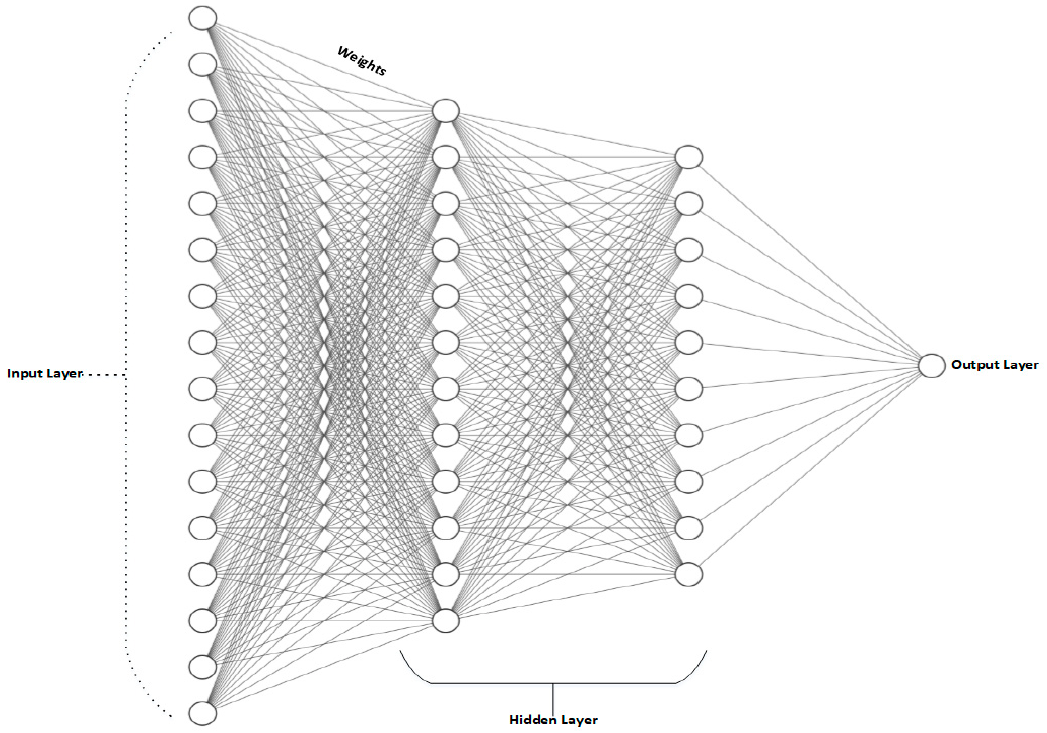
Figure 2. General structure of an artificial neural network (ANN).